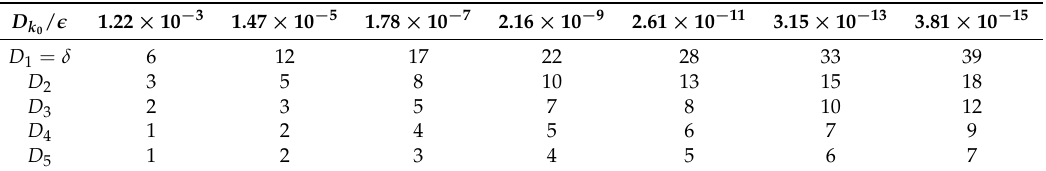
Table 5. Subdivision depth of 4-point interpolating ternary subdivision curves.